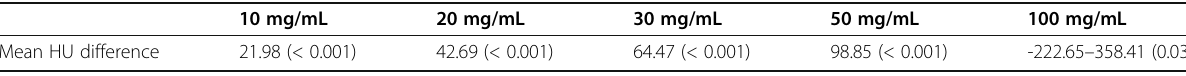
Table 8 Mean difference in HU values between the vendors for all monoenergetic images and iodine concentrations 10